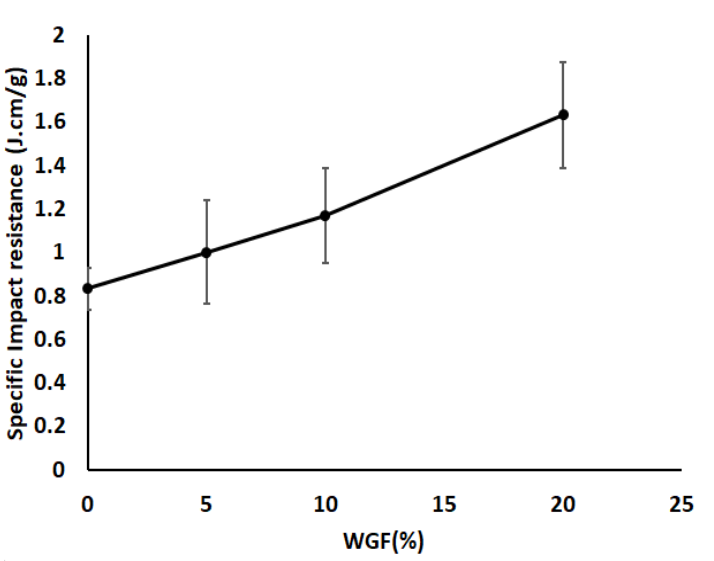
Figure 10. Specific impact resistance of WGF